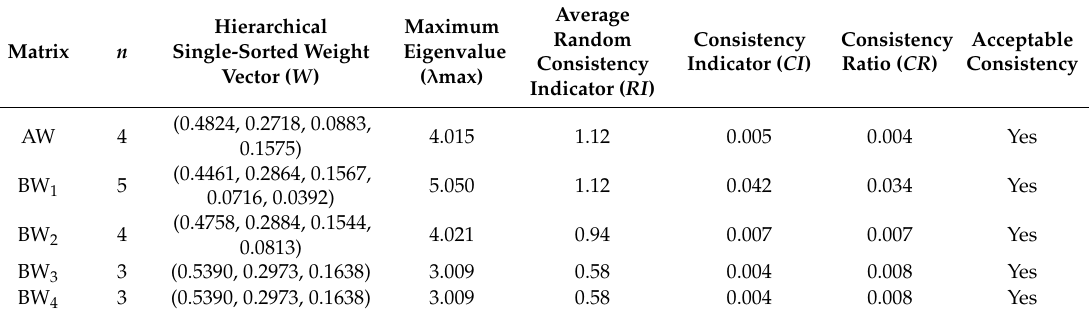
Table 3. Weight vector calculations and one-time test